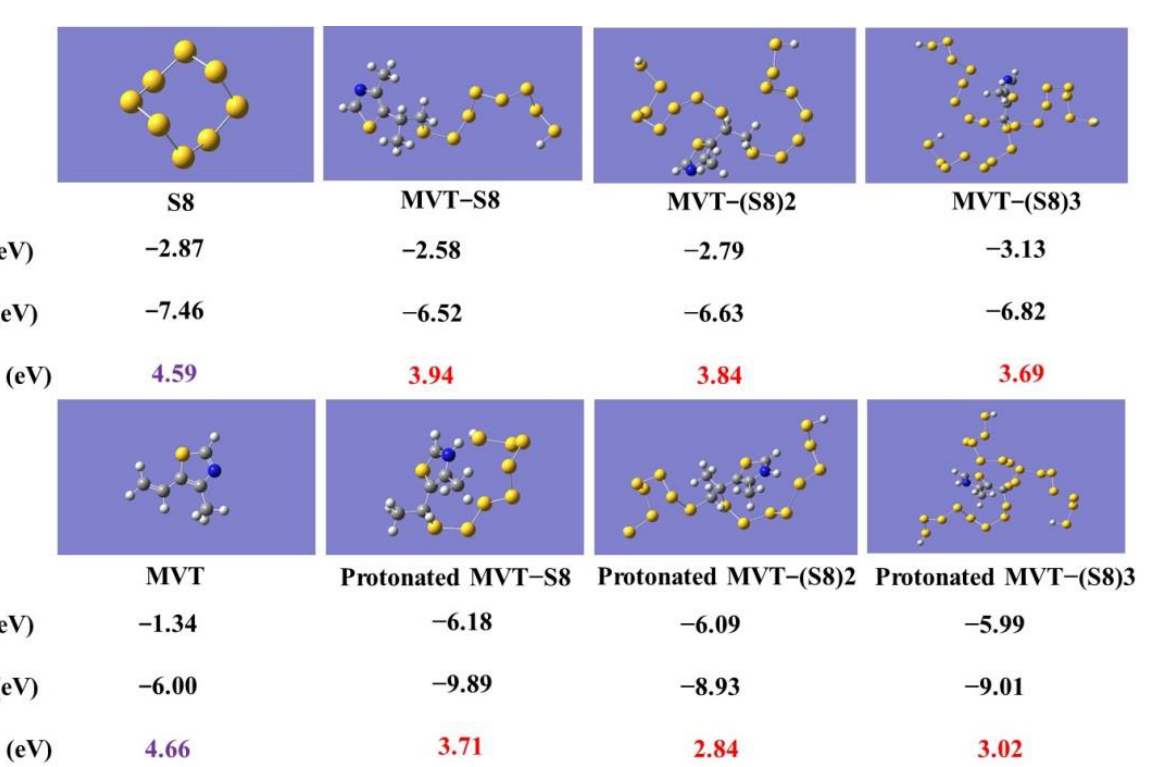
Figure 6. ( a ) Galvanostatic charge – discharge cycling of different poly(S-MVT)s at 0.1 C (capacity calculated based on the mass of poly(S-MVT)) and elemental sulfur (S). ( b ) Rate capacity of the poly(S-MVT) (15% MVT) copolymer and elemental sulfur S based electrodes at varied rates. ( c ) Cyclic voltammograms of the poly(S-MVT) (15% MVT) copolymer cathode at a scan rate of 0.1 mVs −1 . ( d ) Charge – discharge profiles of Li-S batteries with poly(S-MVT) (15% MVT) copolymer cathode at 0.1 C.